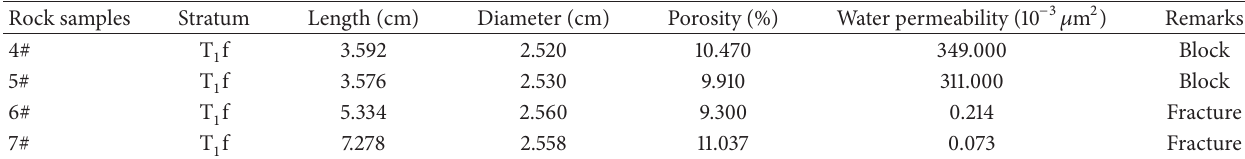
Table 3: Physical properties of rock samples.